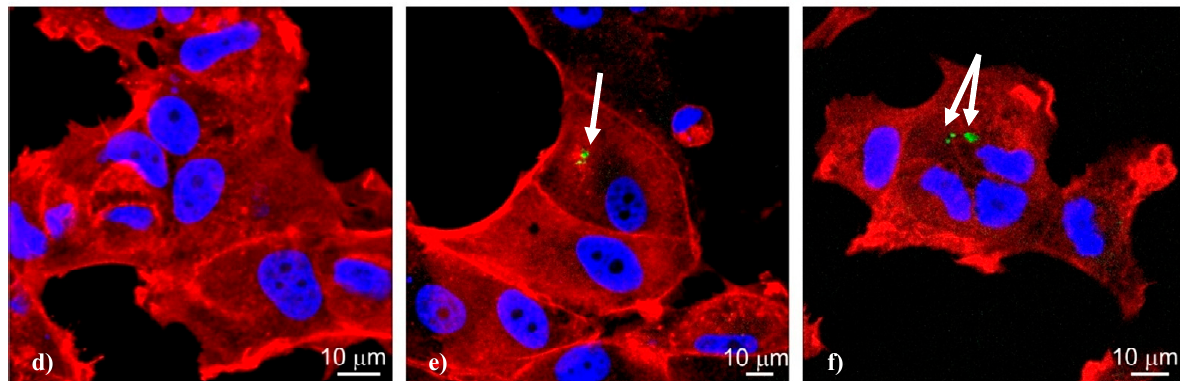
Figure 8. Confocal microscopy images of MCF-7 cells after 24-hour incubation with fluorescein labelled siRNA: ( a ) Bcl-2, ( b ) CBD-1/Bcl-2, ( c ) CBD-2/Bcl-2, ( d ) Mcl-1, ( e ) CBD-1/Bcl-2, ( f ) CBD-2/Mcl-1. The concentration of siRNA was 0.1 µ M and the dendrimer/siRNA charge ratio was 20:1. Arrows indicate complexes dendrimer/siRNA.